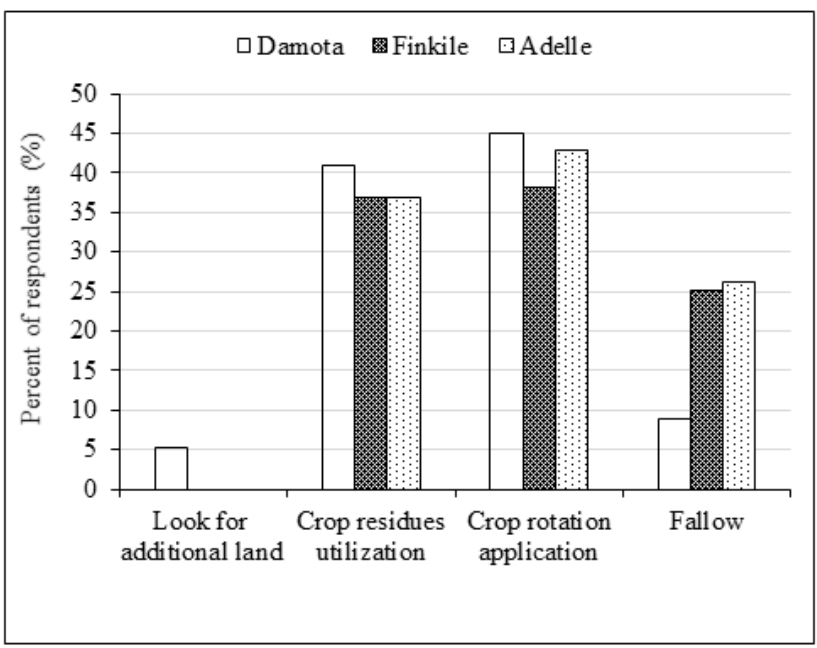
Figure 4. Causes of crop yields decline in the past 10 years of the three selected kebeles of the Haramaya District (Source: Elaborated by the Authors).